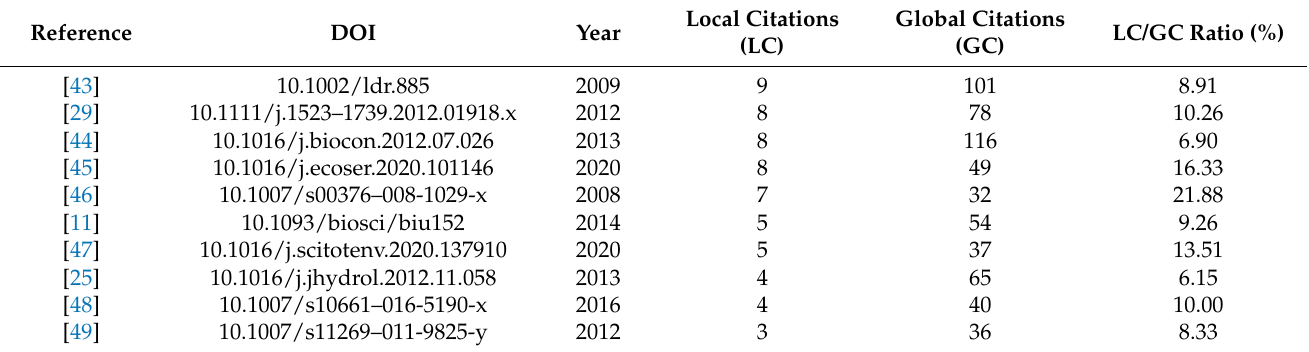
Table 2. Top ten local citation scores (LCS) of publications considering the ecological and environ- mental effects of land use and cover changes (LUCC) on the Qinghai-Tibetan Plateau (QTP).